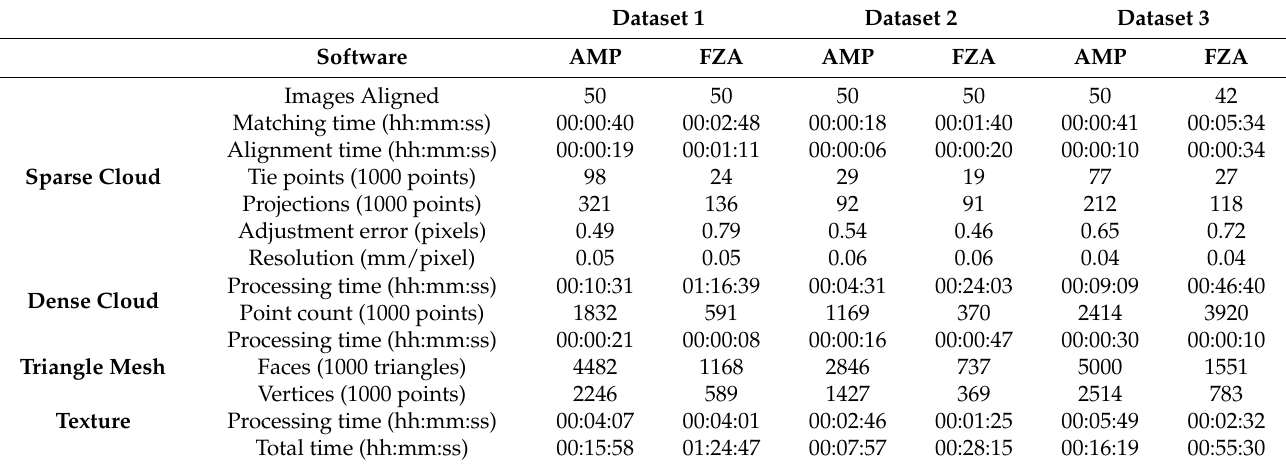
Figure 2. Examples of partial and noise-containing reconstructions (from left to right): dataset 1 ARP, dataset 1 Regard3D 1.0.0 (R3D), dataset 3 VCM, dataset 3 R3D. Table 4. Photogrammetric results, datasets 1–3.